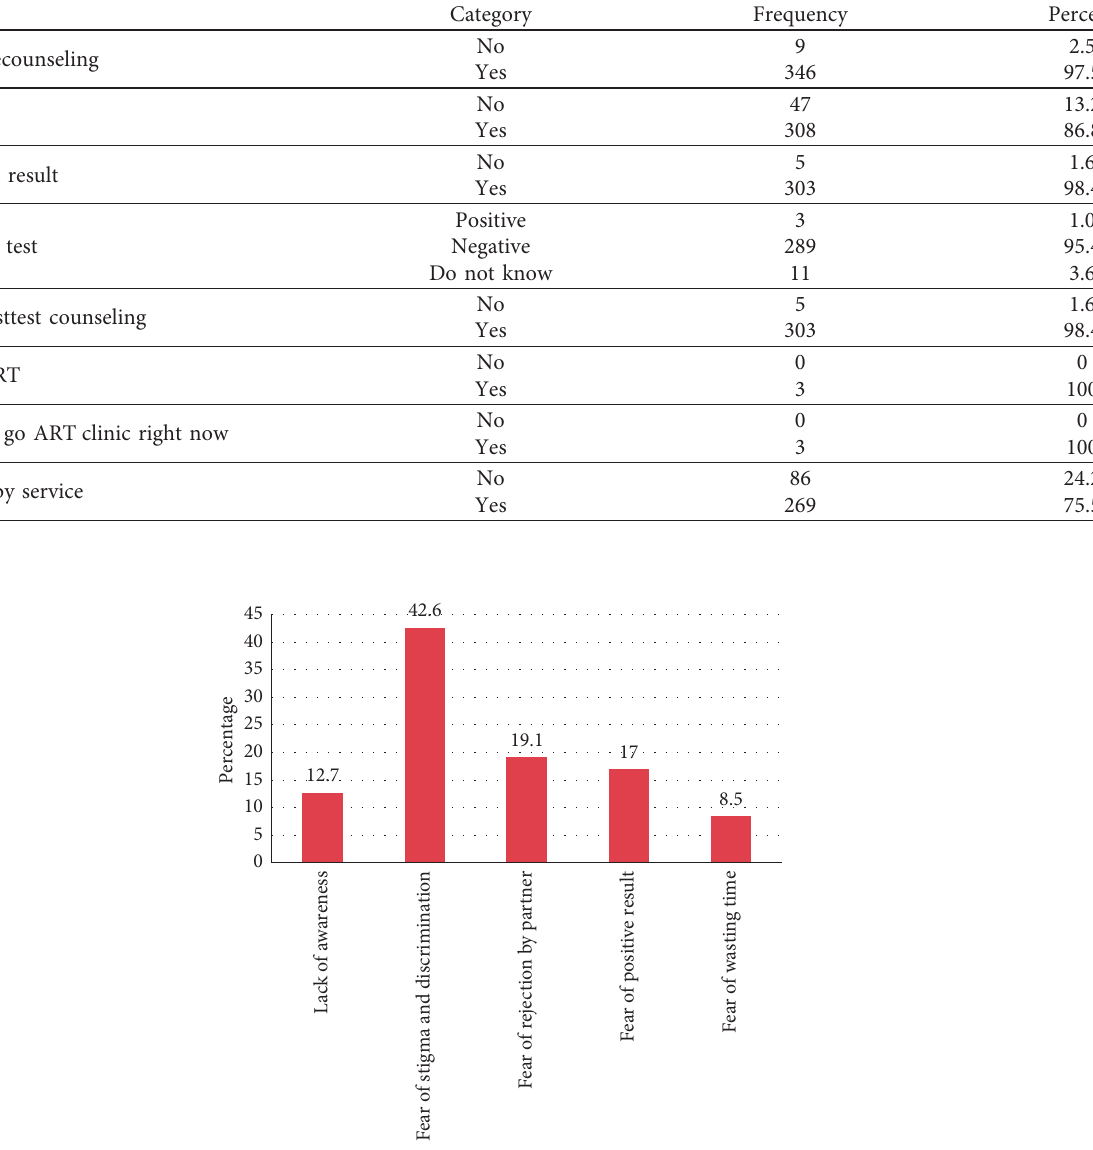
Table 4: HIV testing and counseling as PMTCTservice utilization among pregnant women attending ANC at public health facilities, Debre Berhan Town, June 2018 ( n � 355).